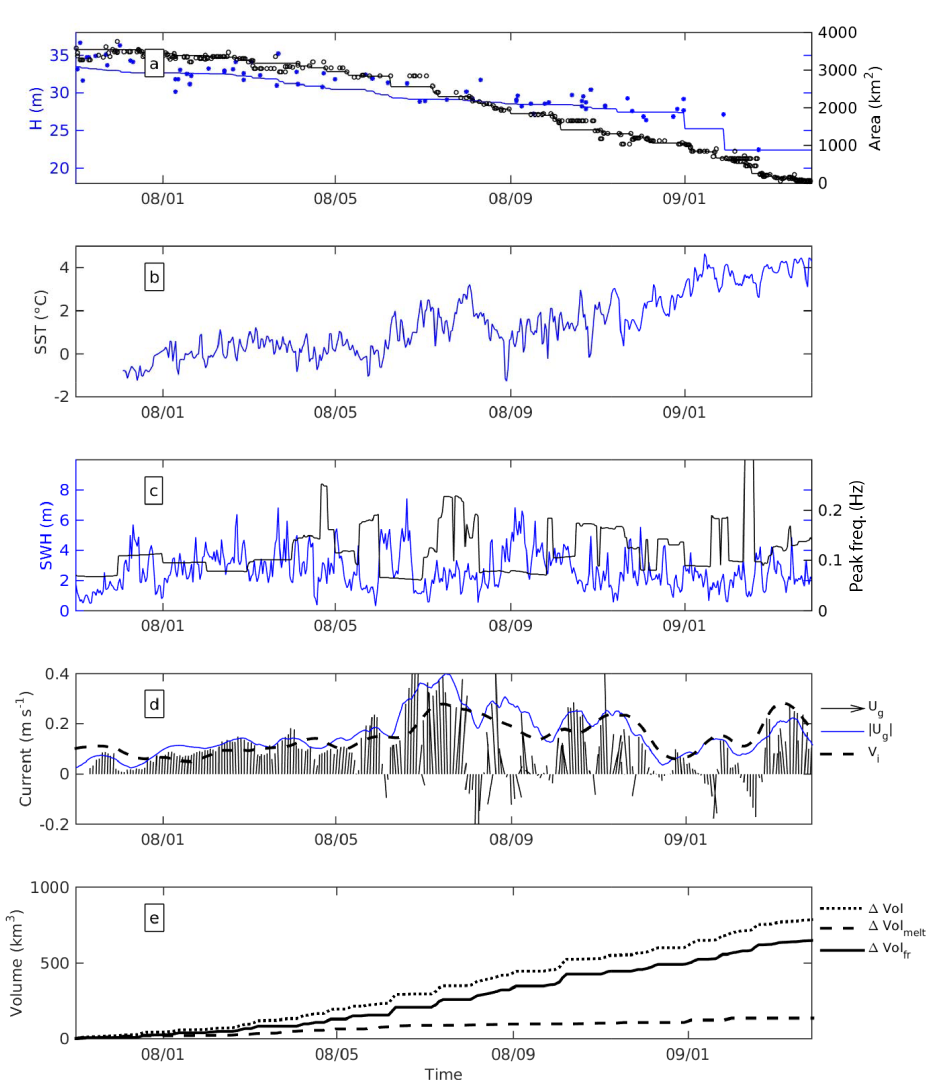
Figure 5. (a) C19a area (in km 2 ) and freeboard (in m). The black and blue lines represent the interpolated daily area and freeboard, and the black circles and blue crosses the MODIS area and altimeter freeboard estimates. (b) ODYSSEA sea surface temperature (in ◦ C). (c) Significant wave height in m (blue line) and peak frequency in Hz (green line). (d) AVISO geostrophic current (black arrows), current velocity (blue line) and iceberg velocity (dashed black line). (e) Total volume loss (dotted line), volume loss by melting (dashed line), and by fragmentation (solid